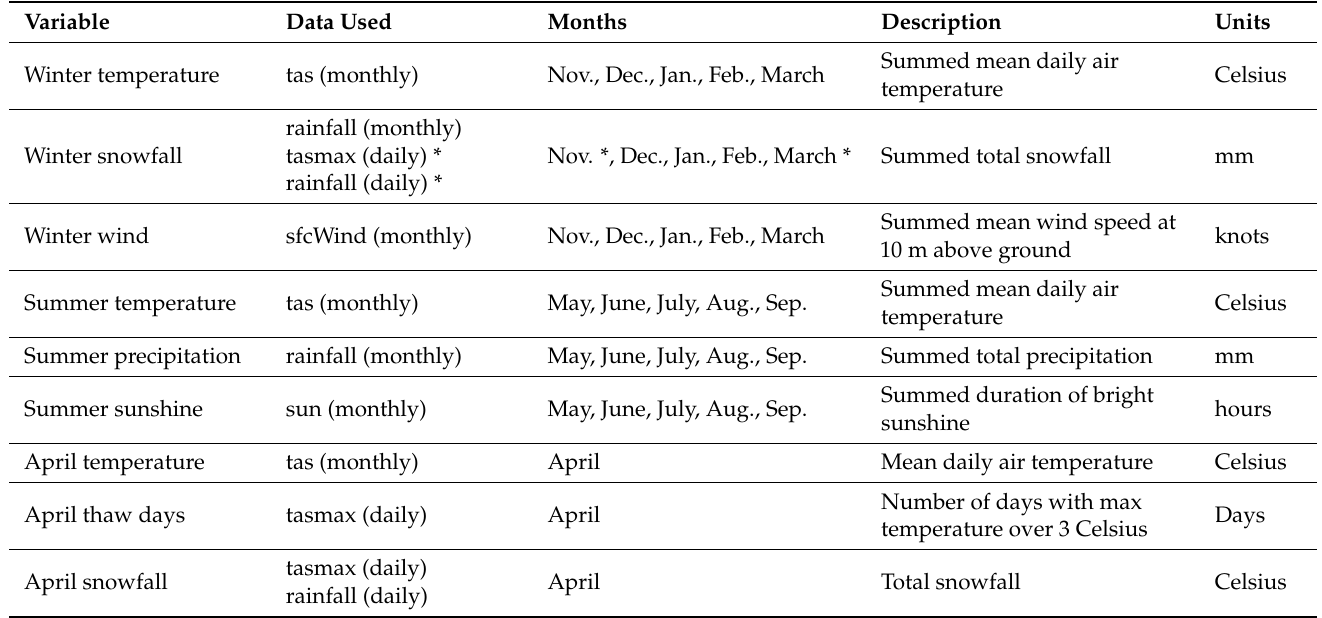
Table 2. Summary of climate variables used in the study. Nov., Dec., Jan., Feb., Aug. and Sep. are November, December, January, February, August and September, respectively. For winter snowfall for the starred months of November and December, daily temperature and precipitation data were used to compute snowfall.